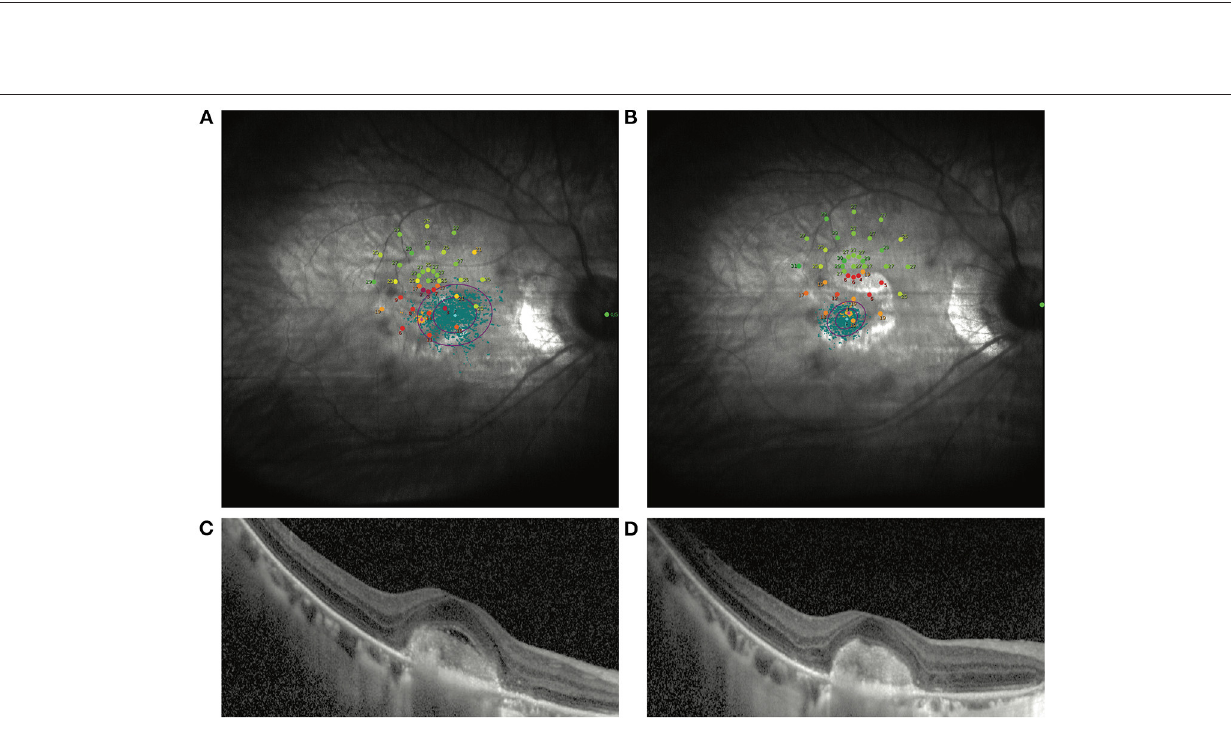
Frontiers in Medicine |